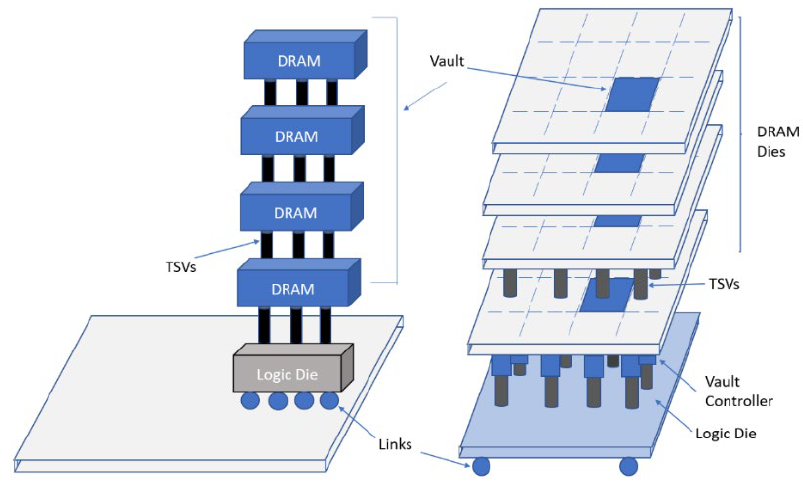
Figure 10. The composition of a vault [7].